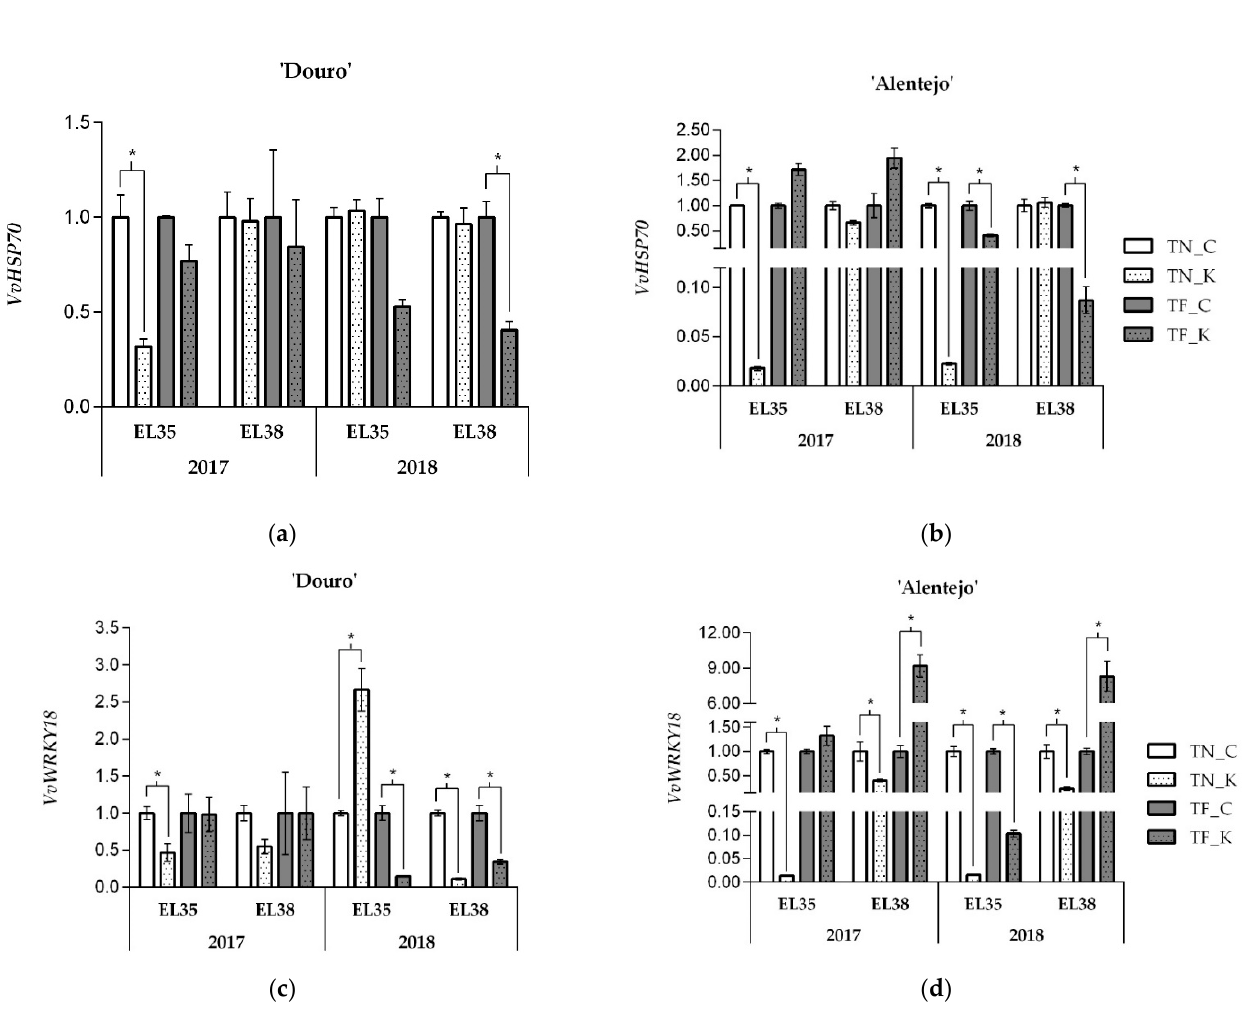
Figure 2. Relative expression of VvHSP70 ( a , b ), and VvWRKY18 ( c , d ) genes of TN and TF grapevine leaves ( Touriga Nacional control-TN_C and kaolin–TN_KL; Touriga Franca control–TF_C and kaolin–TF_KL) at Douro and Alentejo throughout 2017 and 2018 summer seasons. Values are means of three replications ± standard error. * denote significant difference between control and kaolin treated vines of each variety within the same developmental stage (EL35 or EL38).